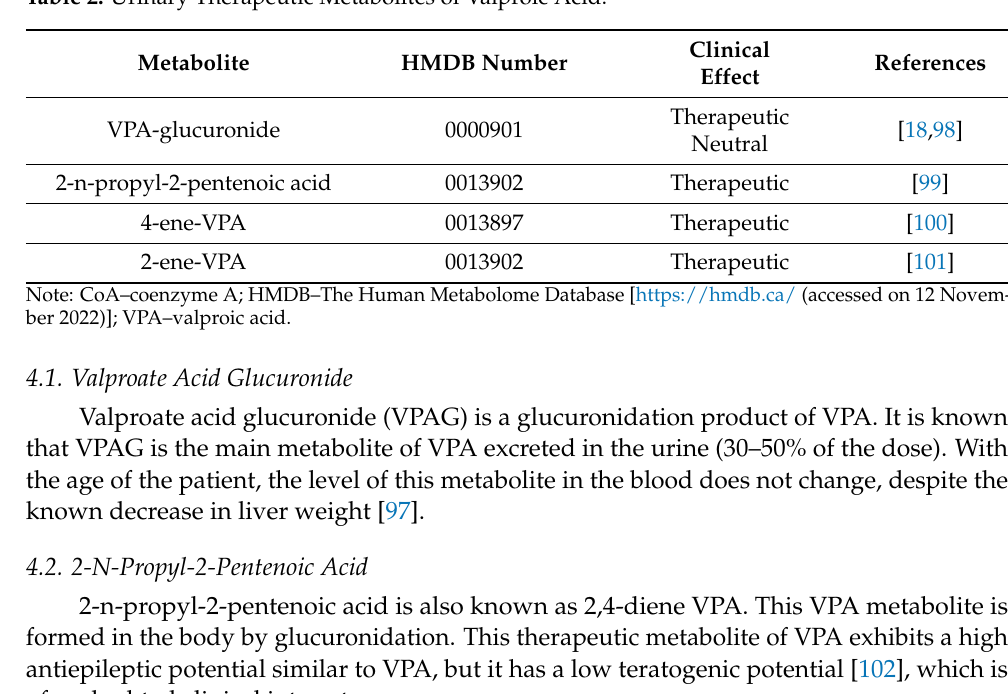
Table 2. Urinary Therapeutic Metabolites of Valproic